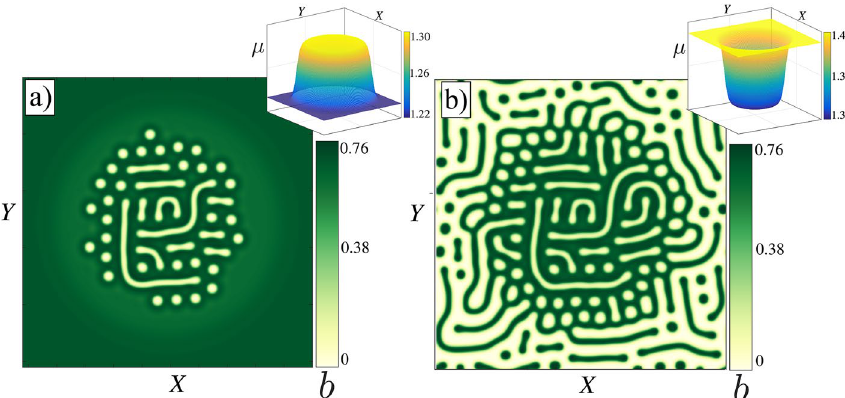
Figure 5. Localised labyrinthine patterns generated by inhomogenous aridity in the integrodifferential model. The spatially forced pattern can be supported by ( a ) the vegetated state (top hat-like shape µ parameter), and ( b ) the bare state (inverted top hat-like shape µ parameter). From numerical simulations, the figure was created using Inkscape 1.0 (https:// inksc ape. org/ relea se/ inksc ape-1.